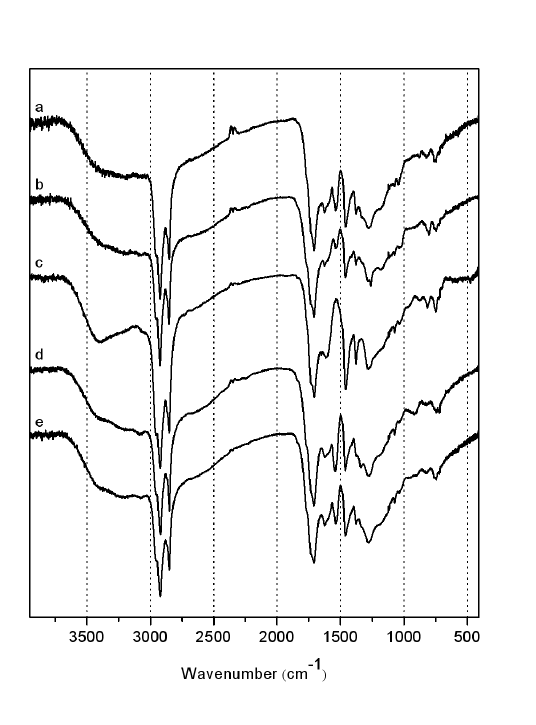
Fig. 7 FTIR spectra of THF extracts: (a) dpf, (b) O 2 /125, (c) O 2 /Na 2 CO 3 , (d) 5 % HNO 3 , (e) PAA.